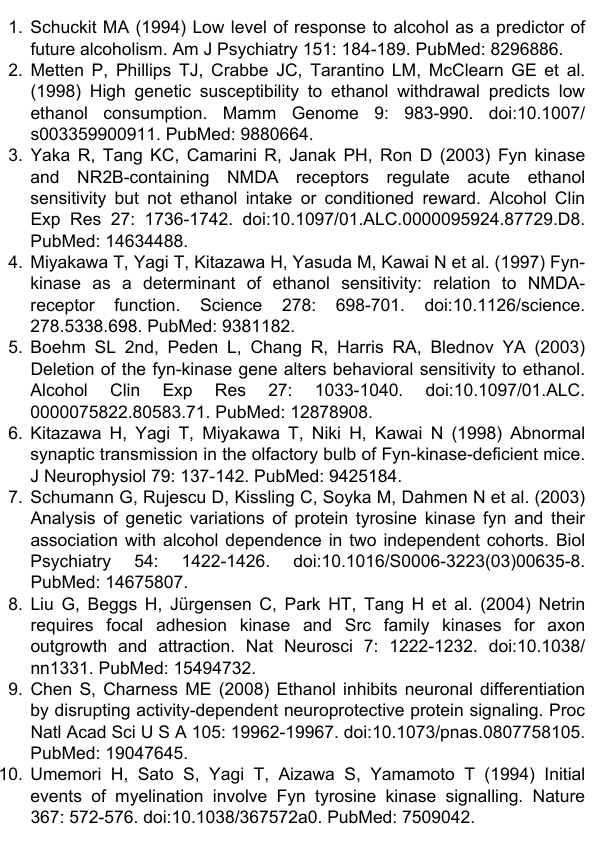
Table S5. Functional over-representation analysis of basal gene expression correlations with Fyn expression or LORR from Figure 4B and Table S4. Results are listed for Molecular Function, Biological Process, Cellular Component, and Mouse Phenotype using the ToppGene Suite at a 5% FDR and trimming groups for containing at least 3 and no greater than 300 members.